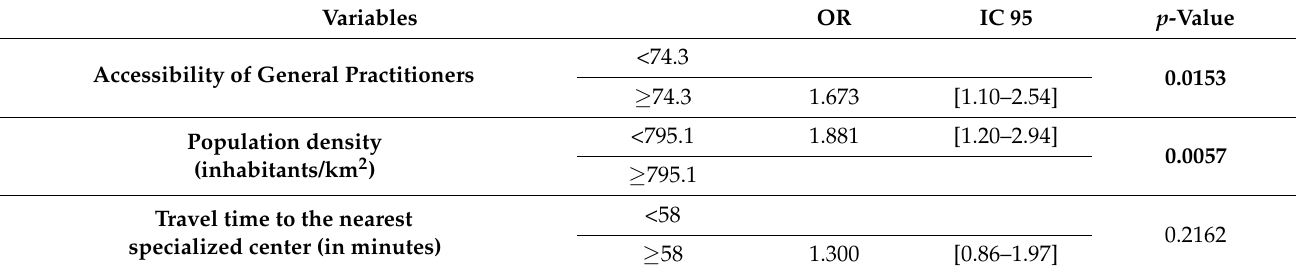
Table 4. Impact of socio-spatial determinants on disease stage at the diagnosis in the global cohort after univariate analysis. p -values < 0.05 are marked in bold